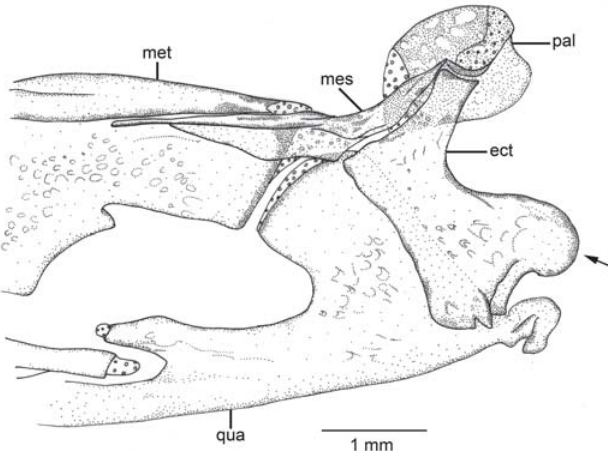
Fig. 2. Anterior region of suspensorium of Laemolyta fernandezi , INPA 12234, 93.7 mm SL, left side, medial view; ect = ectopterygoid, met = metapterygoid, mes = mesoptery- goid, pal = palatine, qua = quadrate. Arrow indicates protu- berance on anteroventral region of ectopterygoid.